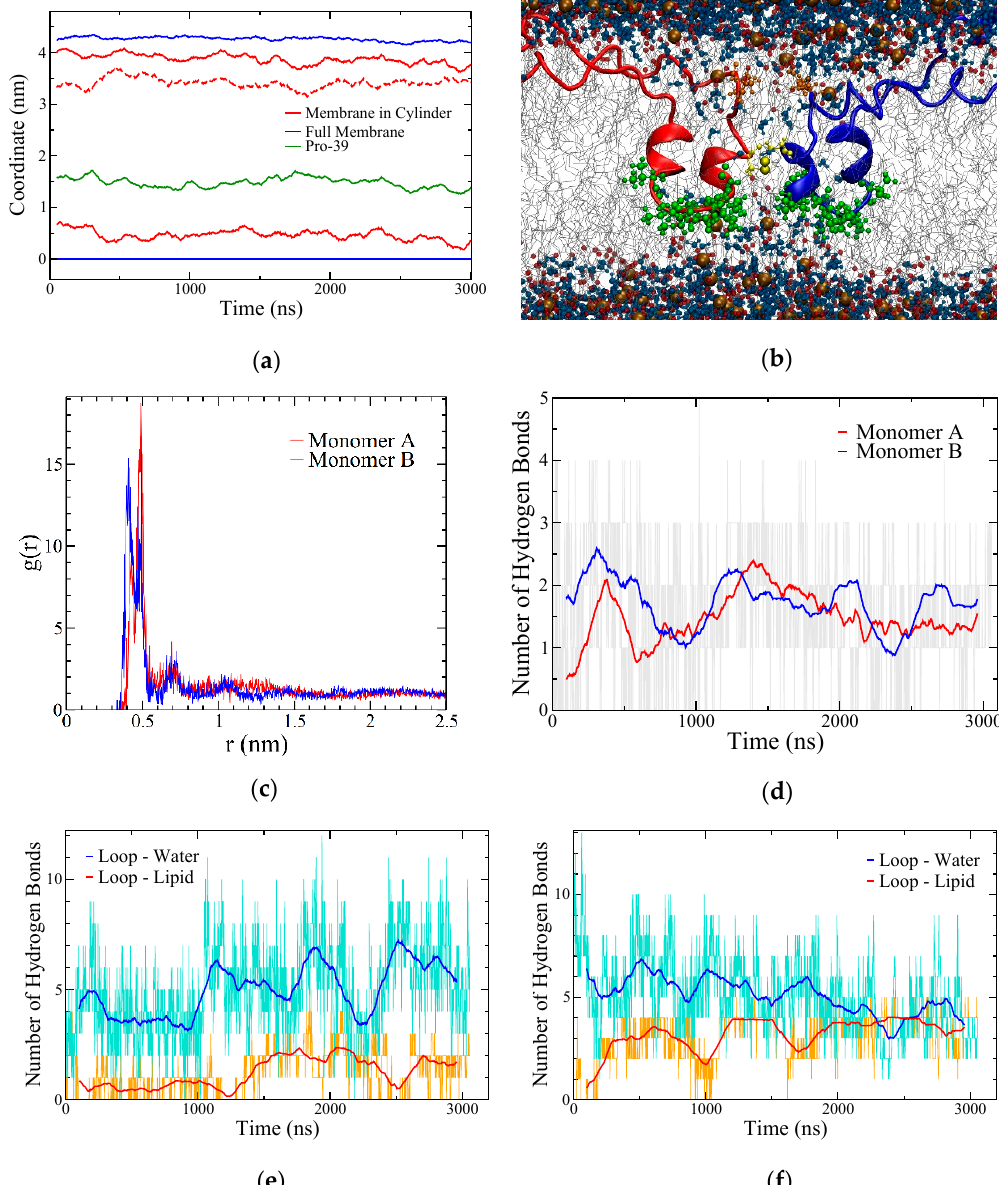
Figure 7. SP-B–lipid interactions in the BI1 system. ( a ) Coordinate plot illustrating bilayer thickness overall (blue) and within a cylinder of 2 nm radius around C48 (red). The maximum density positions of the phosphorous atoms in POPC are shown, with all coordinates referenced to the overall bottom leaflet position. The dotted red line corresponds to the di ff erence between the red lines (i.e., bilayer thickness near the protein). The average position of the two P39 residues is also shown (green) as a measure of the position of the central loops. The data are running averages over 50 points. ( b ) Snapshot at 2.0 µ s with R52 sidechain heavy atoms shown as orange balls and sticks, the central loop region from residues 37 to 45 shown in green, and C48, which links the subunits, in yellow. The phosphorous and oxygen atoms in the lipids are shown as brown and red spheres, respectively, and water molecules are shown as blue balls and sticks. ( c ) Radial distribution function of phosphorus atoms in lipids to the terminal side-chain carbon in R52 averaged over the last half of the simulation. ( d ) Time evolution of hydrogen bonding from both R52 residues to POPC headgroups. Grey lines show unaveraged data. ( e , f ) Hydrogen bonding between the central loop region of SP-B (residues 37–45) and lipid (orange) and water (cyan), plotted separately for each SP-B subunit. In ( d – f ) the running averages are over 100